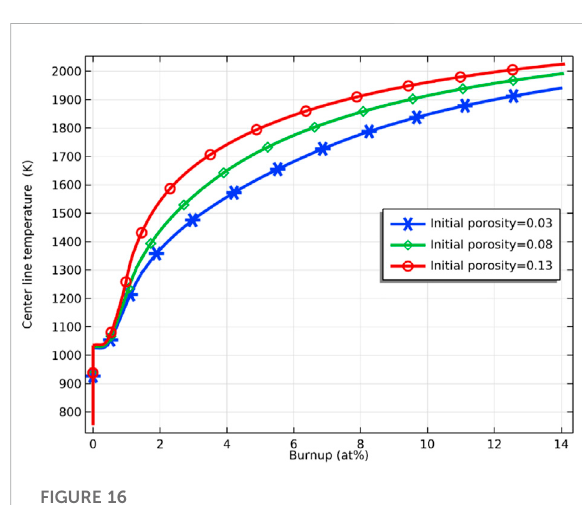
FIGURE 15 Variation of fuel thermal conductivity with porosity.